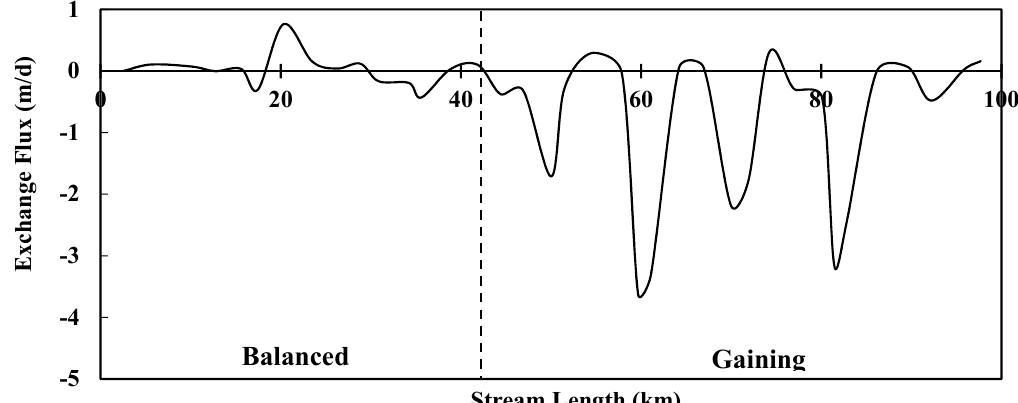
Figure 8. Stream-aquifer interaction along the main stream.